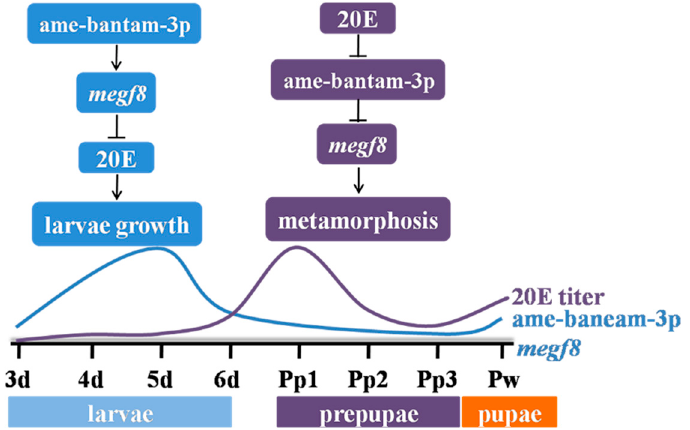
Figure 10. Mechanism explaining the functions of ame-bantam-3p and megf8 during larval–pupal development in the honeybee.